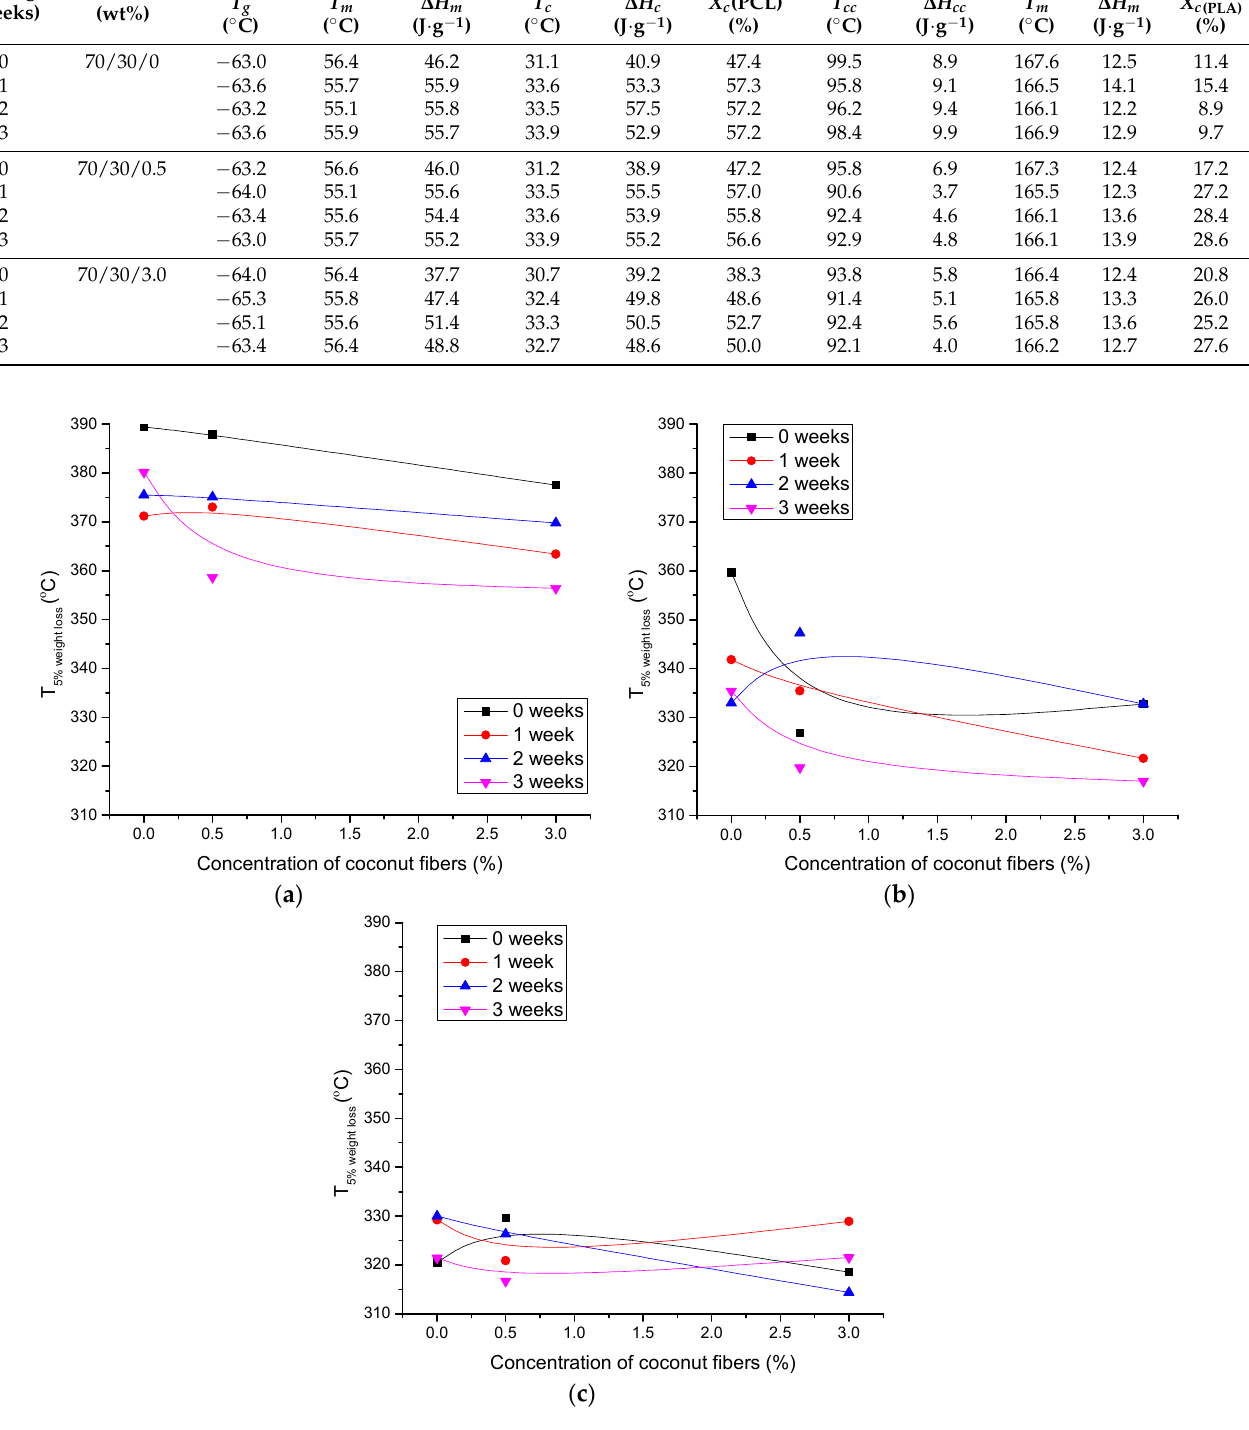
Figure 5. 5% weight loss temperature for polymer blends as a function of coconut fiber concentration: ( a ) PCL-0, ( b ) PCL/PLA 80/20 and ( c ) PCL/PLA